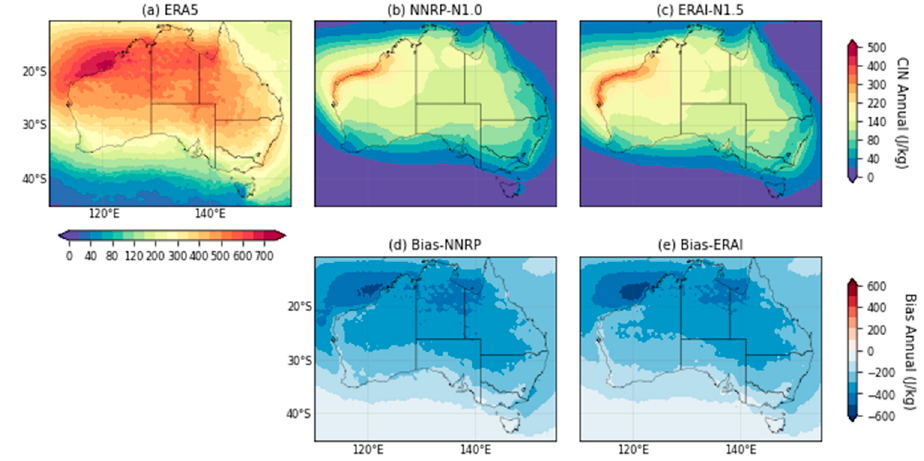
Figure 6. As in Figure 5 except for CIN.